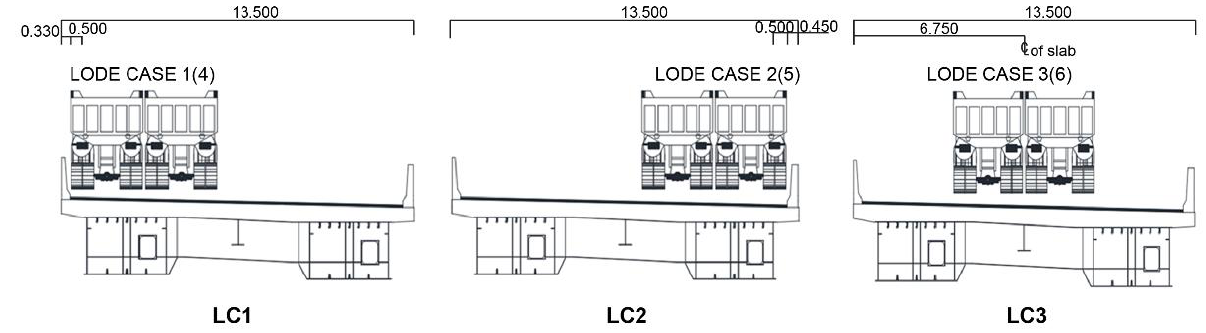
Figure 7. Positions of the test loading truck during the static loading test.